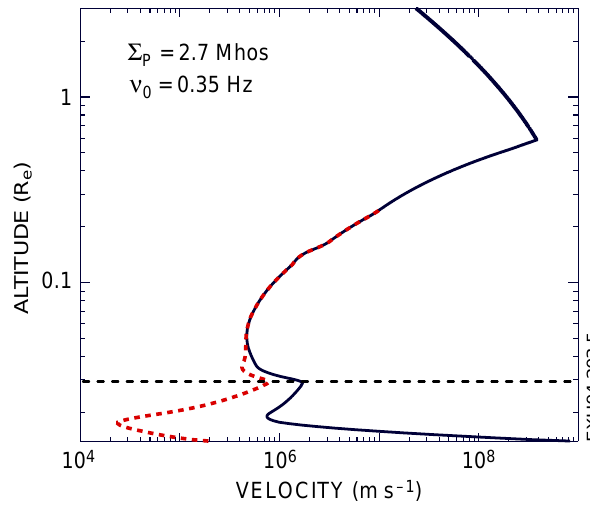
Fig. 2. Schematic of the physical model. The eigenmodes for the model will be found